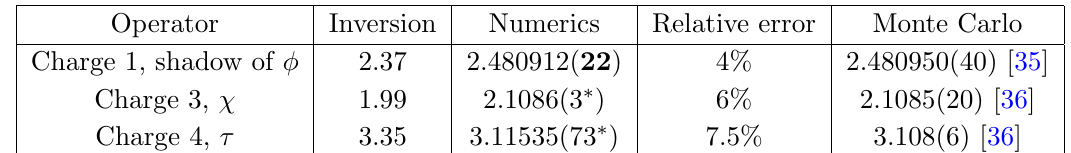
Table 6 . Predictions from the inversion formula versus numerical bootstrap values for the leading scalar operator dimensions. For the relative error between the inversion formula and numerical bootstrap methods, we use the formula predictions come from evaluating the [ (cid:30)s ] 1 a comparison to Monte Carlo